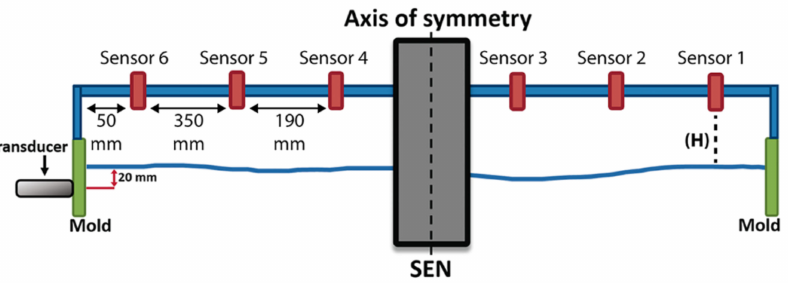
Figure 2. Schematization of the meniscus level sensors and the ultrasonic transducer in the mold to measure